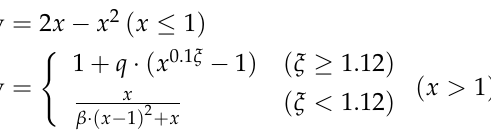
Figure 5. Stress–strain curves of steel. For concrete, there are two types of constitutive relations between the outer concrete and core concrete of segmental precast concrete-filled steel tubular piers. The stress–strain relationship proposed by Han Linhai [22] is for the core concrete, as shown in Figure 6, the expression is as follows: